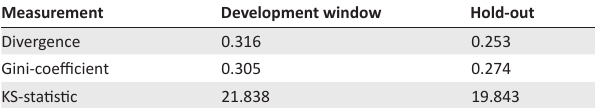
FIGURE 6: Bad rate for accepts and rejects (at observation). TABLE 6: Internal application scorecard performance measures results.